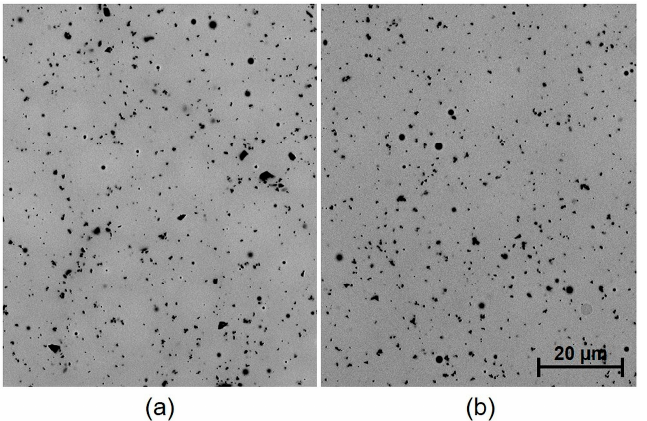
Figure 9. SEM image of the surface of fired paste QQ550: ( a ) 1 layer and 1 firing (specimen group 3); ( b ) 1 layer and 1 firing, followed by a two-hour annealing (525 °C).